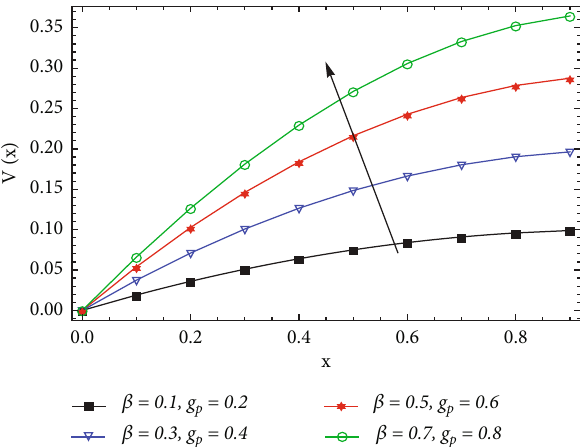
Figure 8: In drainage case e ff ect of increasing β and g where α = 0 : 95 is fi